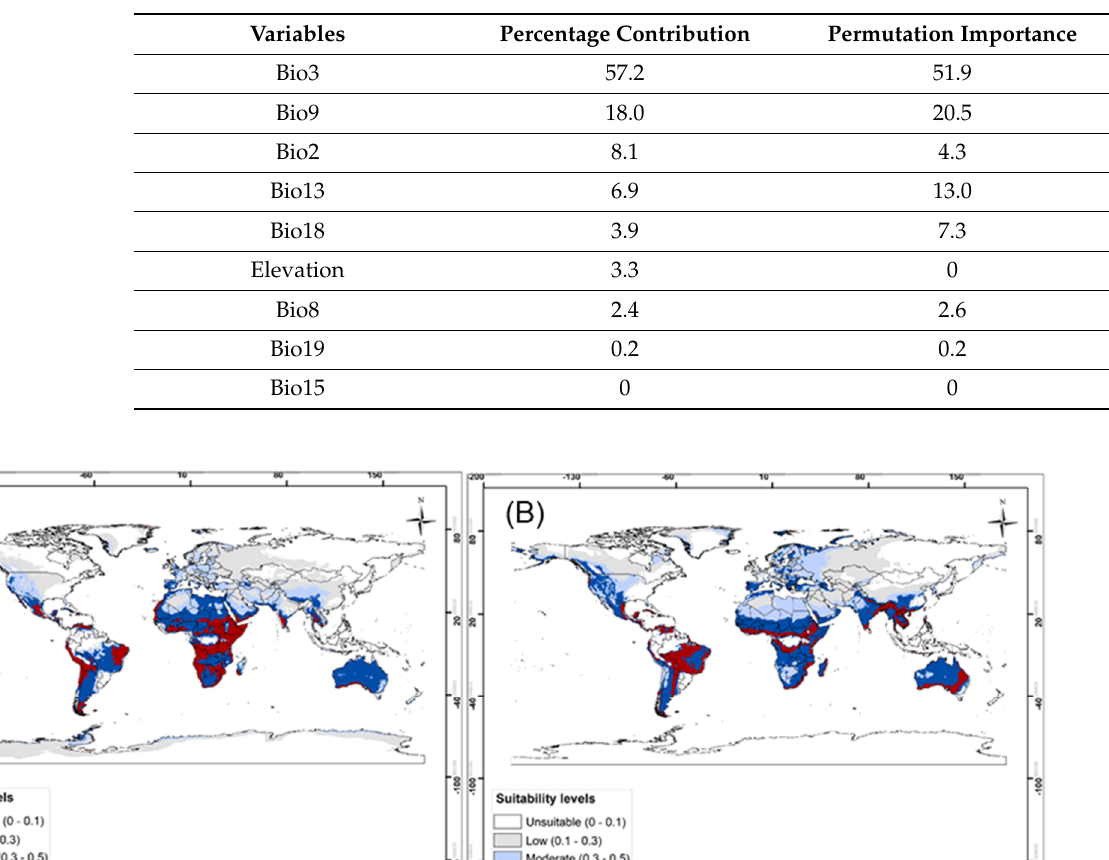
Table 4. Relative contribution of the various bioclimatic variables for Stenomesius sp. near japonicus ecological niche modeling.